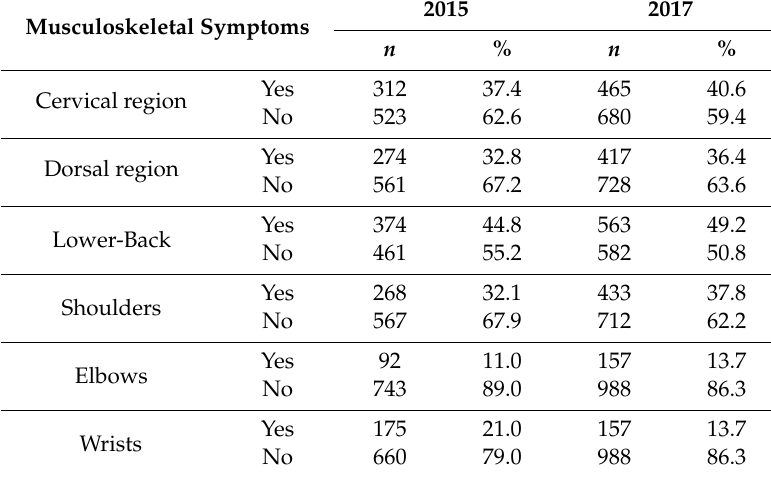
Table 4. Musculoskeletal symptoms in the last 12 months among study participants in 2015 and